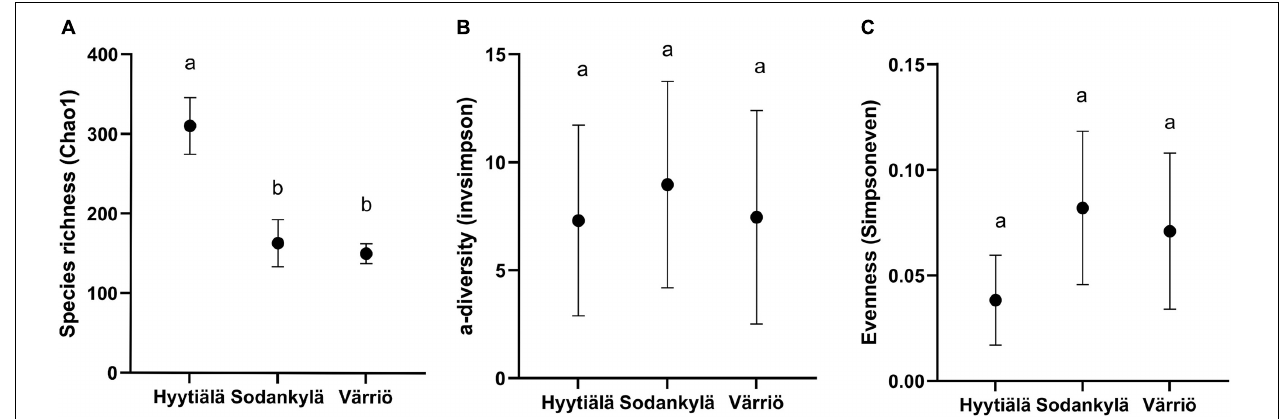
FIGURE 1 | The fungal community (A) species richness (Chao 1), (B) diversity [inverse Simpson’s index (1/D)], and (C) evenness [Simpson’s equitability (ED)] in the three locations between Hyytiälä (southern), Sodankylä (northern) and Värriö (subarctic) boreal pine forests. Values in the figure was shown by the mean with standard deviation ( n = 6 for Hyytiälä, n = 5 for Sodankylä, and n = 10 for Värriö) and letters (a and b) in the figure showing the significance at 95% confident level between locations.